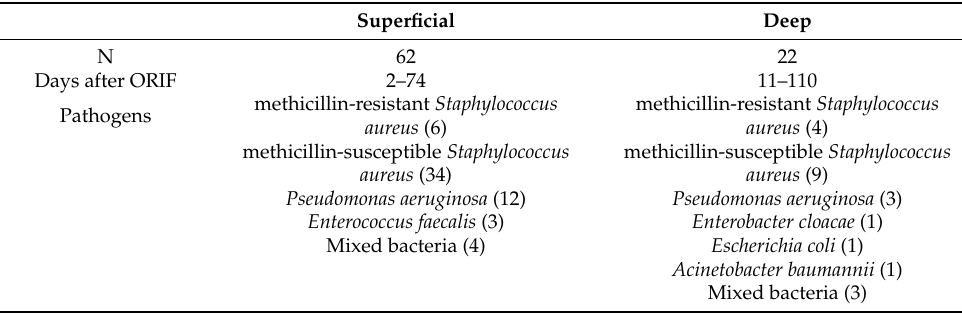
Table 2. Characteristics of postoperative surgical site infection ( n =